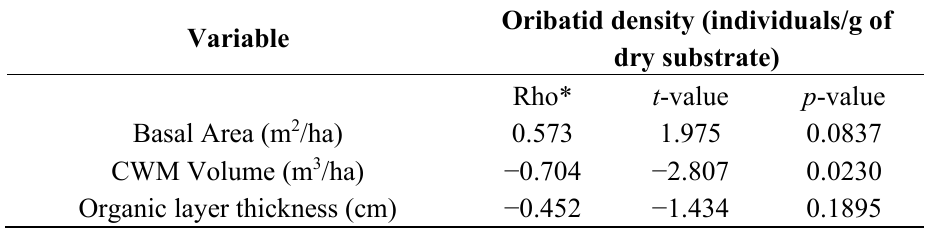
Table 4. Pearson-product moment correlations between adult oribatid density (log transformed) and stand-level measurements for basal area, volume of coarse woody material and organic layer thickness (tests based on df =